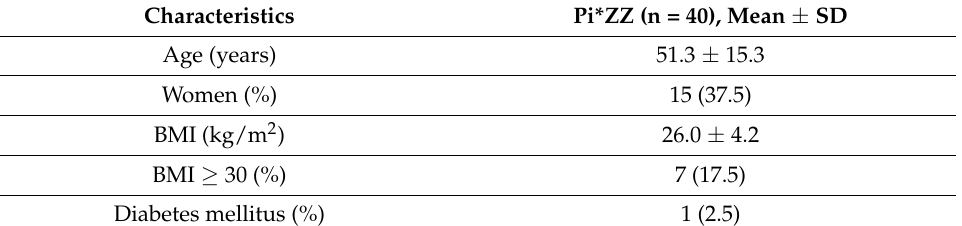
Table 2. Characteristics of the liver patient